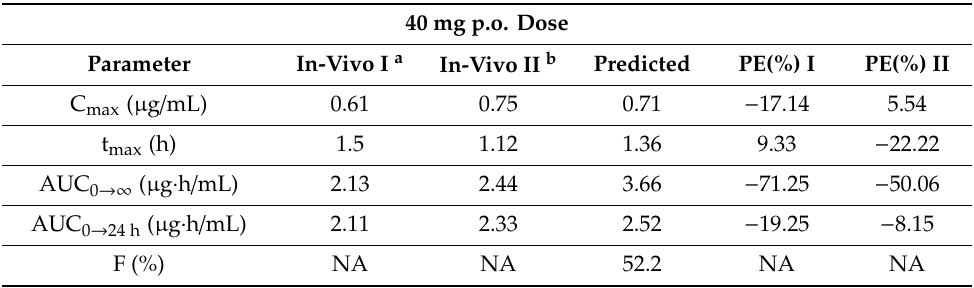
Figure 4. GastroPlus ® simulated (line) versus mean observed (markers) plasma concentration profiles following p.o. administration of furosemide. Mean observed values represent 40 mg immediate-release (IR) tablet profile I [43] and 40 mg IR tablet profile II [37]. Table 4. Comparison between GastroPlus ® simulated and in-vivo observed furosemide pharmacokinetic parameters following p.o. drug administration.